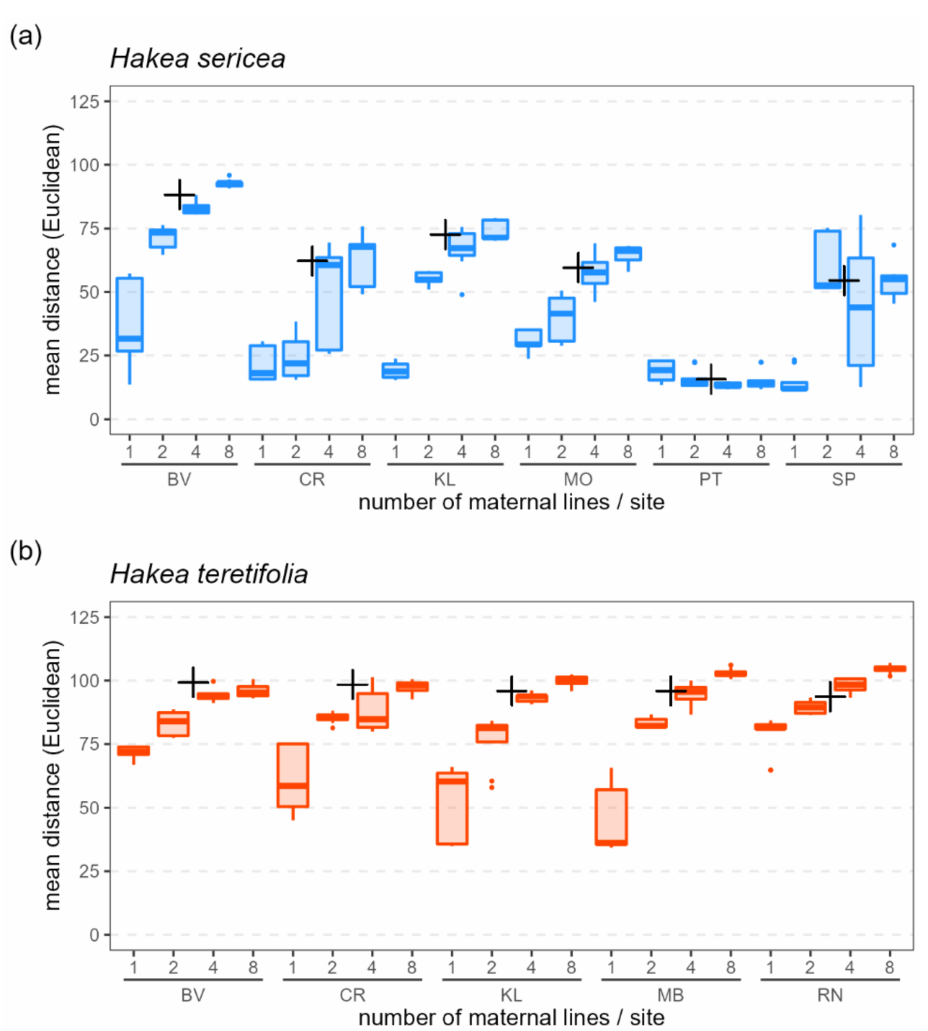
Figure 5. Genetic diversity (as average of pairwise Euclidean distances) among replicate subsamples of 8 seedlings per site for ( a ) H. sericea and ( b ) H. teretifolia according to 4 different sampling strategies (8 seedlings from 1 mother, 4 seedlings from 2 mothers, 2 seedlings from 4 mothers, 1 seedling from each of 8 mothers). Plotted for each site are averages among replicate sets of 8 seedlings randomly resampled 10 times per sampling scheme (boxplots), and average among the mother plants (+). In both species, among-site seedling subsamples captured higher proportions of alleles when more sites were sampled (Figure 6). The maximum allele capture proportion increased as the minimum allele frequency threshold increased (i.e., as only increasingly common alleles were considered; Figure S6). For common alleles (those found on a landscape scale at ≥ 5% frequency), the proportion captured was lower, and the range in proportion captured was higher, among H. sericea resampling replicates compared with H. teretifolia (this pattern remained consistent even when the two most geographically distant H. sericea populations were removed; data not shown). In H. sericea , allele capture proportion ranged from 47% (2 sites) to 91% (6 sites). In H. teretifolia , allele capture proportion ranged from 76% (2 sites) to 96% (5 sites). No resampling replicate captured 100% of the common alleles in either species. Capturing 90% of the common alleles required at least 3 sites in H. teretifolia and at least 6 sites in H. sericea ; capturing 80% of the common alleles required at least 2 sites in H. teretifolia and at least 4 sites in H. sericea (Figure